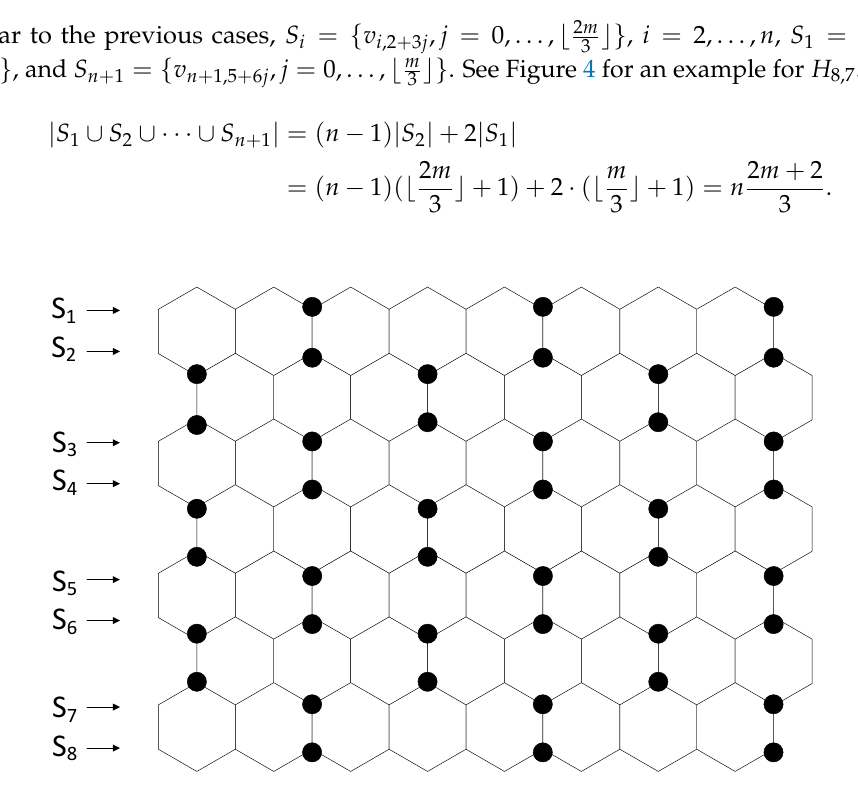
Figure 4. S 1 ∪ S 2 ∪ · · · ∪ S 8 on H 8,7